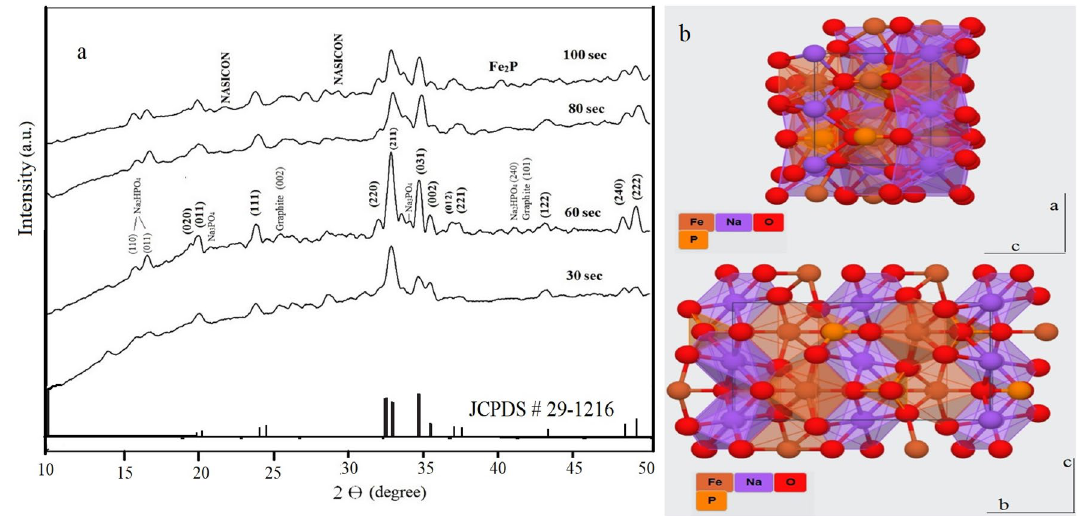
Figure 2. ( a ) XRD patterns of microwave solid state synthesized sodium iron phosphate samples, ( b ) structure of maricite